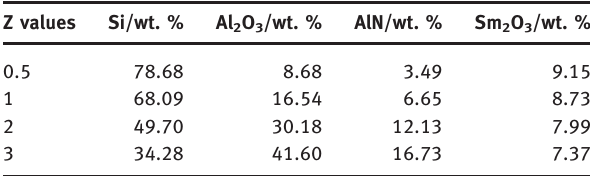
Table 1: Starting compositions of β -SiAlON with different Z values. Z values Si/wt. % Al  O  /wt. % AlN/wt. % Sm  O  /wt. %  .